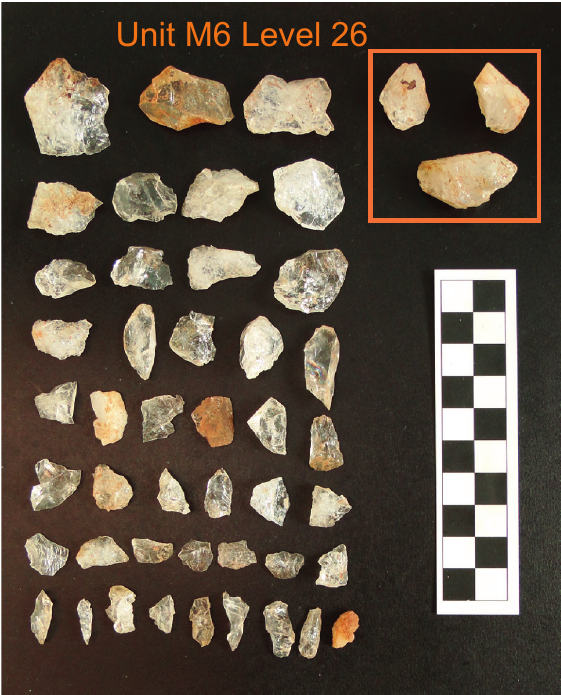
Figure 10 - Sample of cores (inside box) and flakes from Unit M6, Level 26, dated ca. 10,000 cal BP.